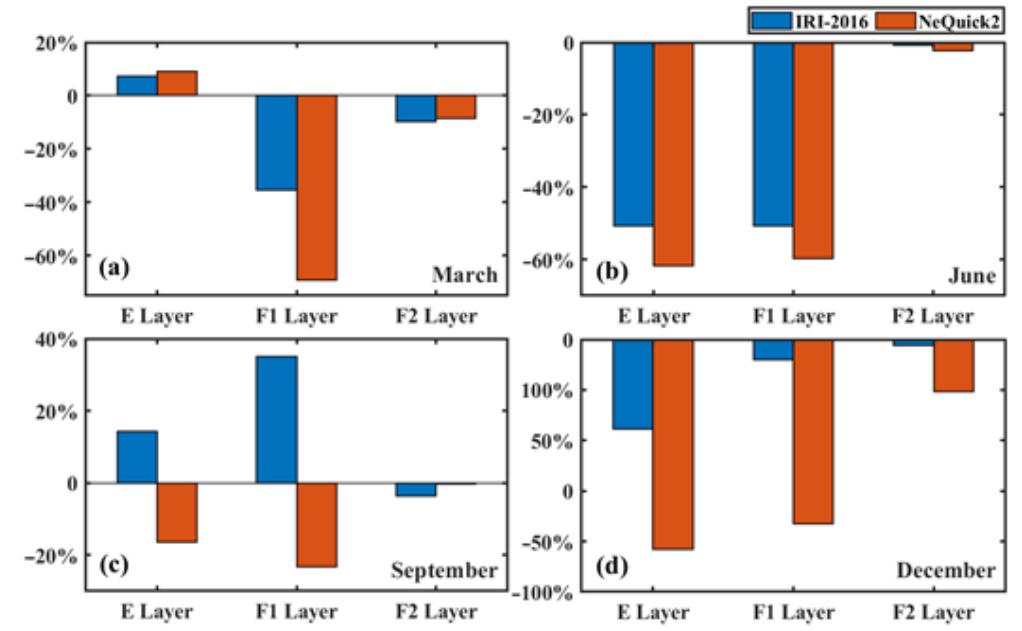
Figure 6. Statistics on the rate of misestimation of models in each ionosphere layers. E, F1, and F2 layers represent the altitude range of 100 – 140 km, 140 – 210 km, and 210 – 800 km, respectively. Figures ( a ), ( b ), ( c ), and ( d ) mean statistical results in March, June, September, and December, respectively.